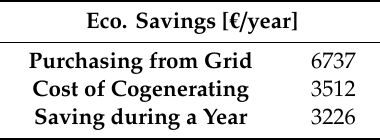
Table 6. Savings with self-produced electricity when covering heating